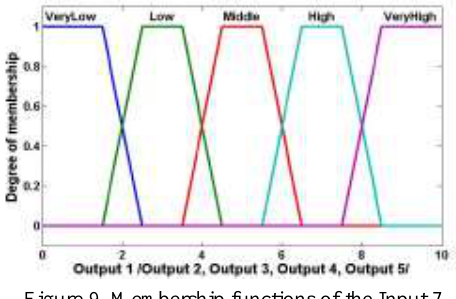
Figure 9. Membership functions of the Input 7